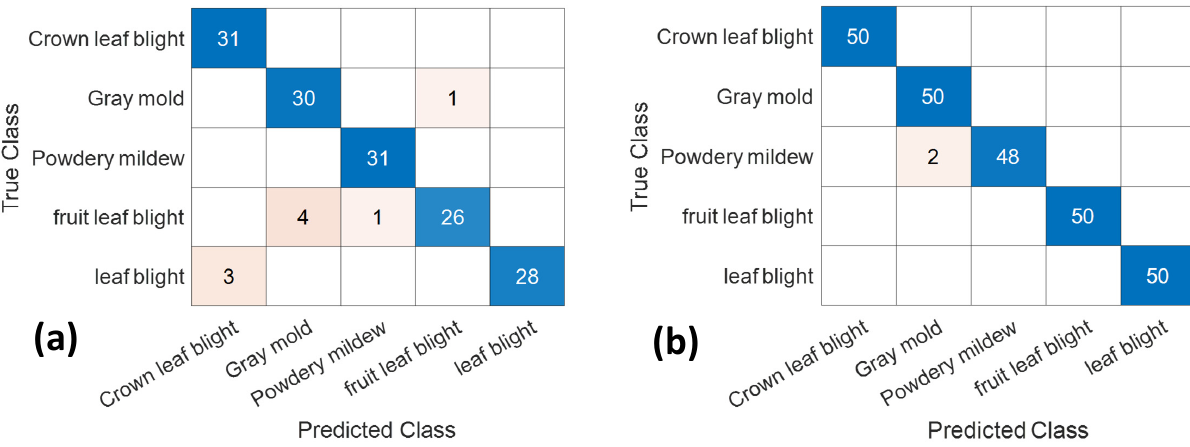
Figure 2. Confusion matrix with the VGG16 model of 20 epochs of the ( a ) original dataset, and ( b ) feature